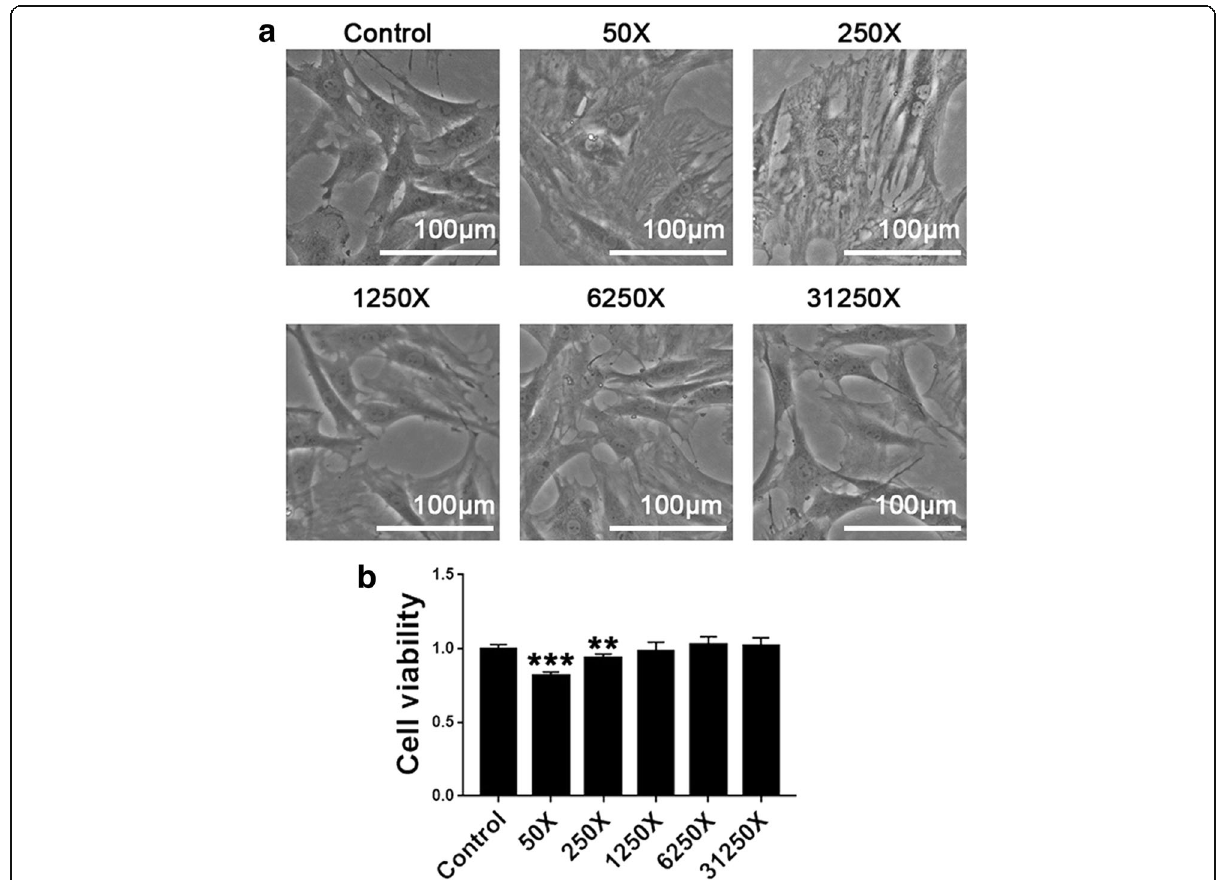
Fig. 2 Evaluation of cytotoxicity of different concentrations of Osteoking on rat bone marrow mesenchymal stem cells. a Cell morphology after culturing with different concentrations of Osteoking for 4 days in bright light. X = dilution multiple of Osteoking. b Cell viability of rat bone marrow mesenchymal stem cells (rbMSCs) treated with different concentrations of Osteoking after 4 days by CCK-8 assay. ** p < 0.01, *** p < 0.001 vs. control; n =